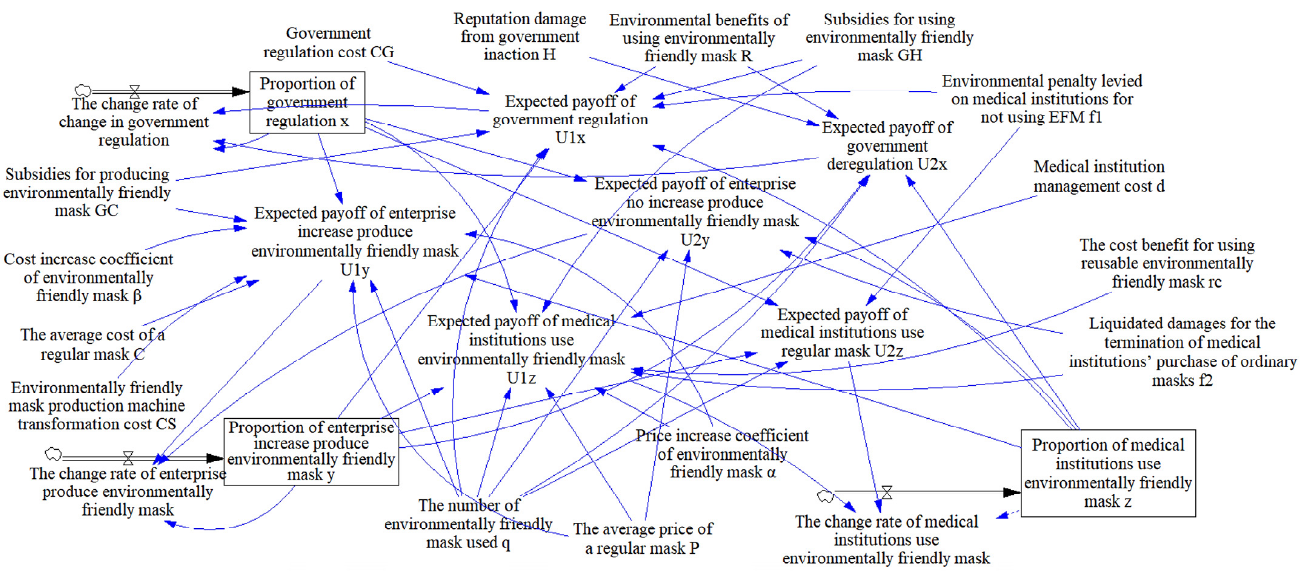
Figure 7. The system dynamics model of governments, enterprises, and medical institutions.